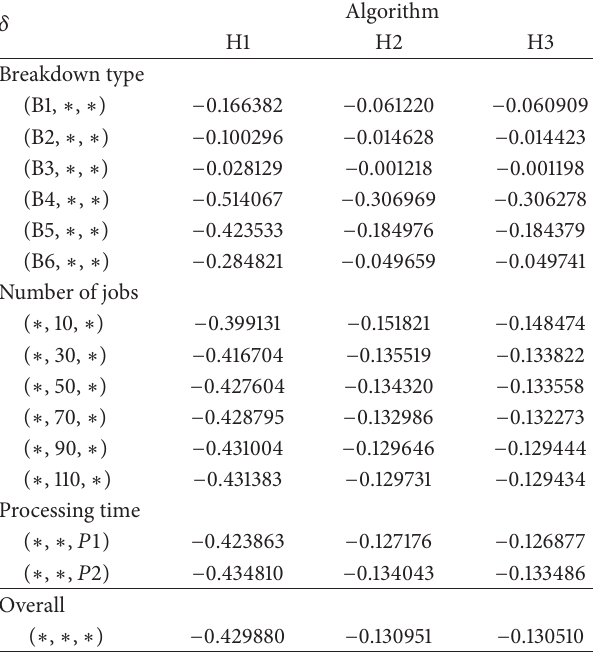
Table 4: ACD values for the